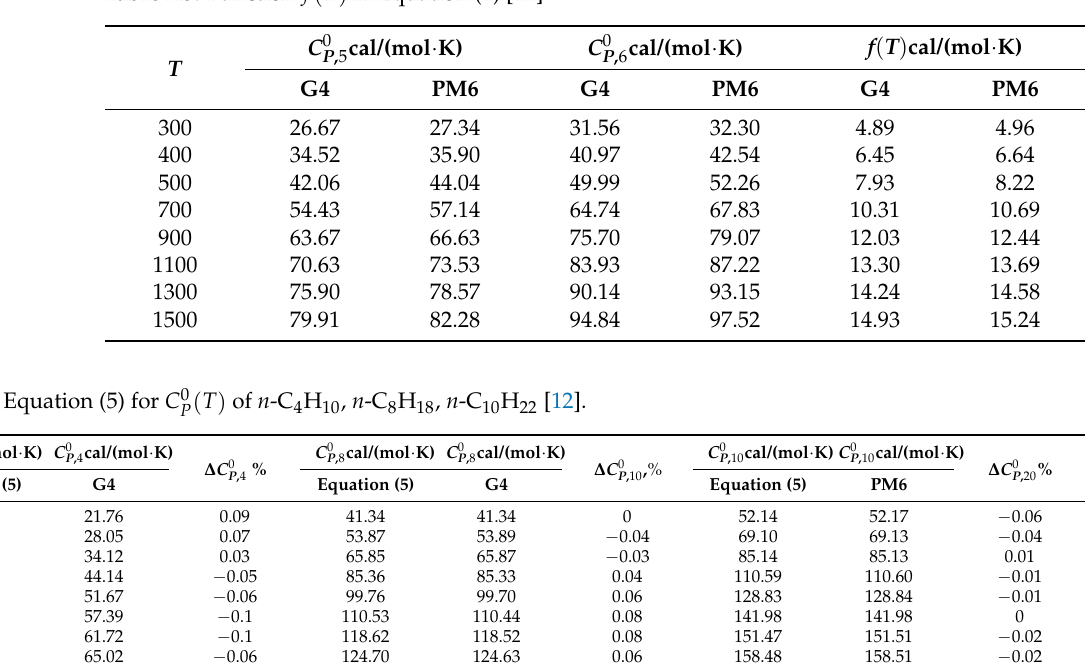
Table A3. Function f ( T ) in Equation (4) [12].